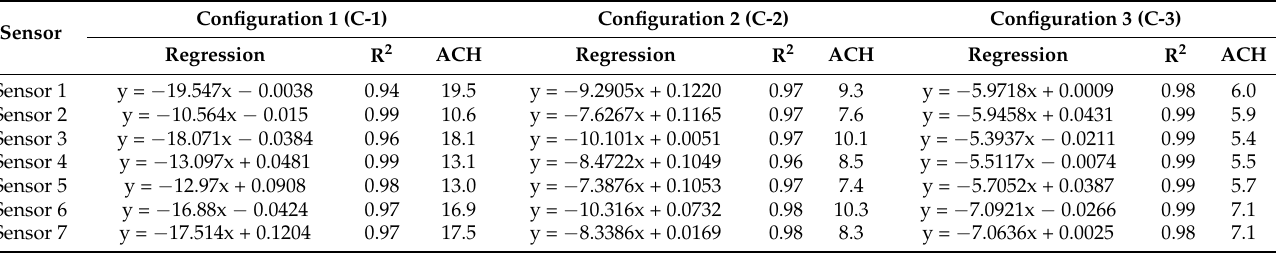
Table A4. Decay curves in Classroom